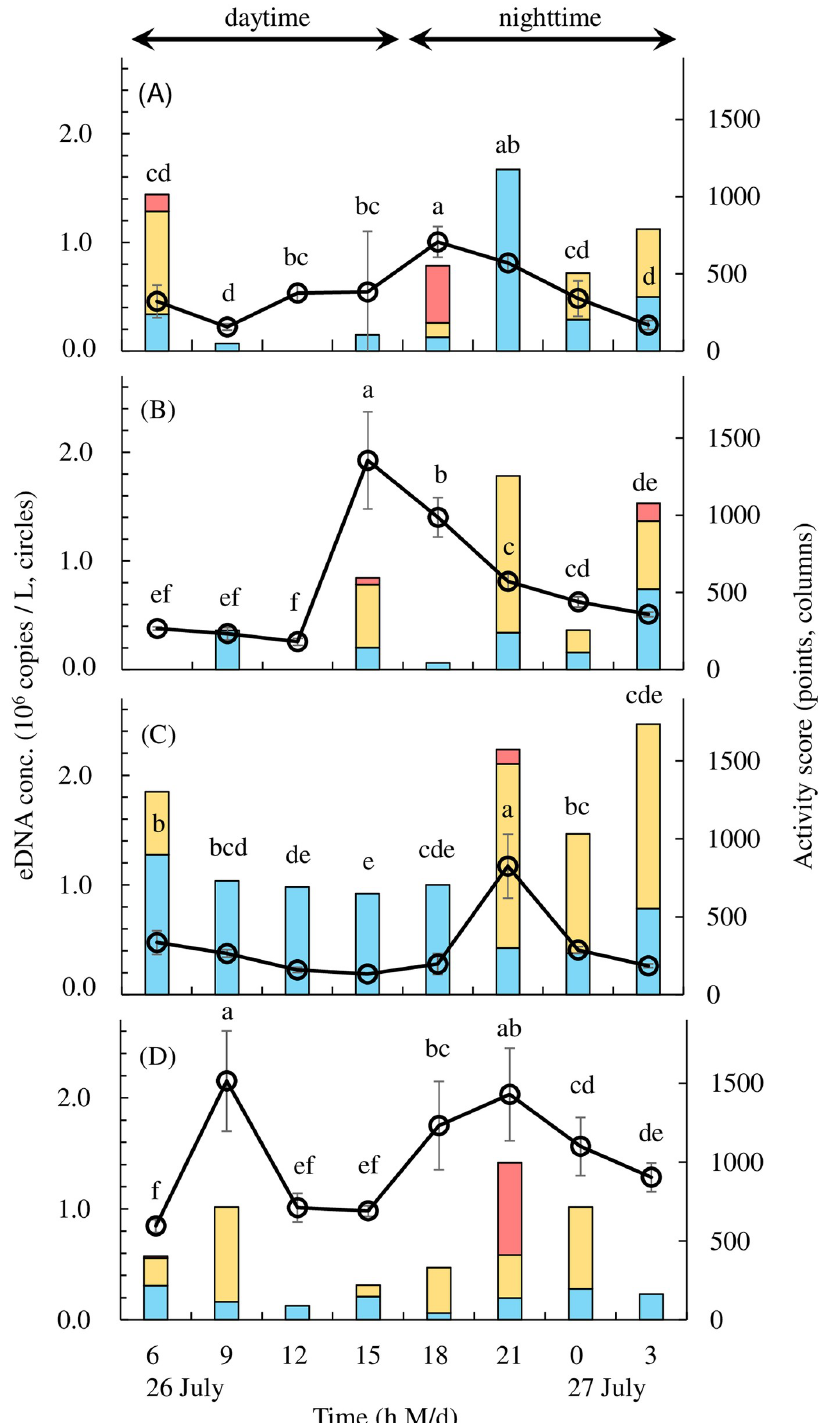
Fig 3. Diel changes in eDNA concentration (eDNA conc.) (circles; left axis) and activity (columns, blue: 1, yellow: 2, red: 3; right axis) in Japanese eels. (A) Aja-1, (B) Aja-2, (C) Aja-3, (D) Aja-4. There were significant differences in eDNA concentration ( df = 3, p = 0.03) and activity ( df = 3, p < 0.01) between daytime and nighttime (two-tailed, paired Student’s t -test). There were significant differences in eDNA concentration among times of day ( df = 7, p < 0.05, one-way ANOVA with Tukey‘s HSD multiple comparisons test). Error bars indicate standard deviations.